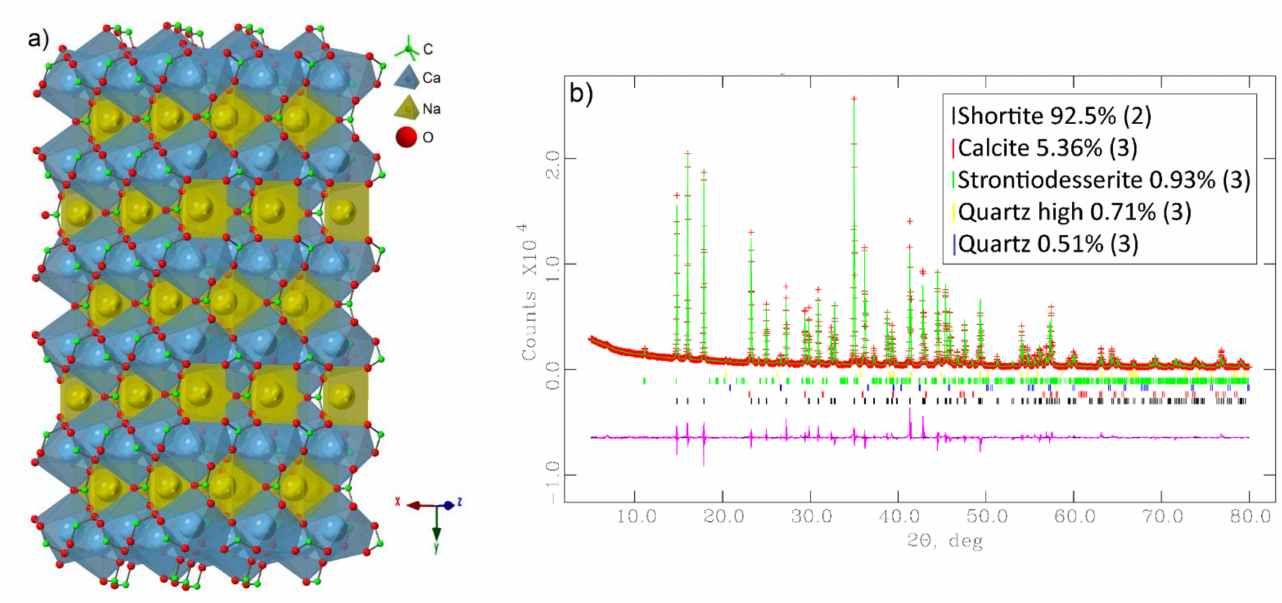
Figure 5. ( a ) Crystal structure of shortite [74]. The sticks represent the C . . . O bonds. ( b ) The X-ray diffraction spectrum of the sample defined as shortite collected at room temperature refined by the Rietveld method [60] with Rp.